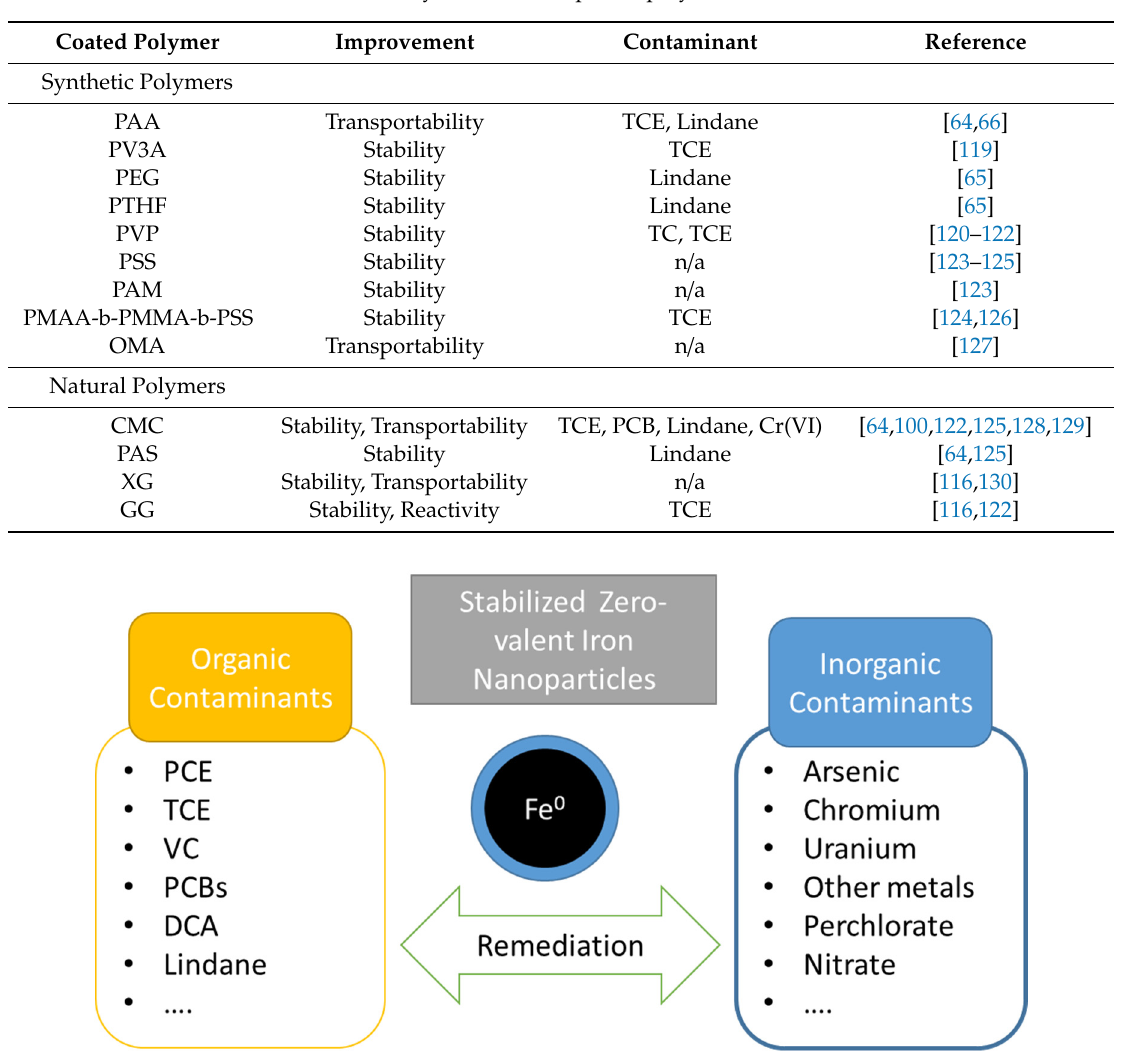
Figure 7. Summary of the main contaminants remediated with stabilized NZVI.